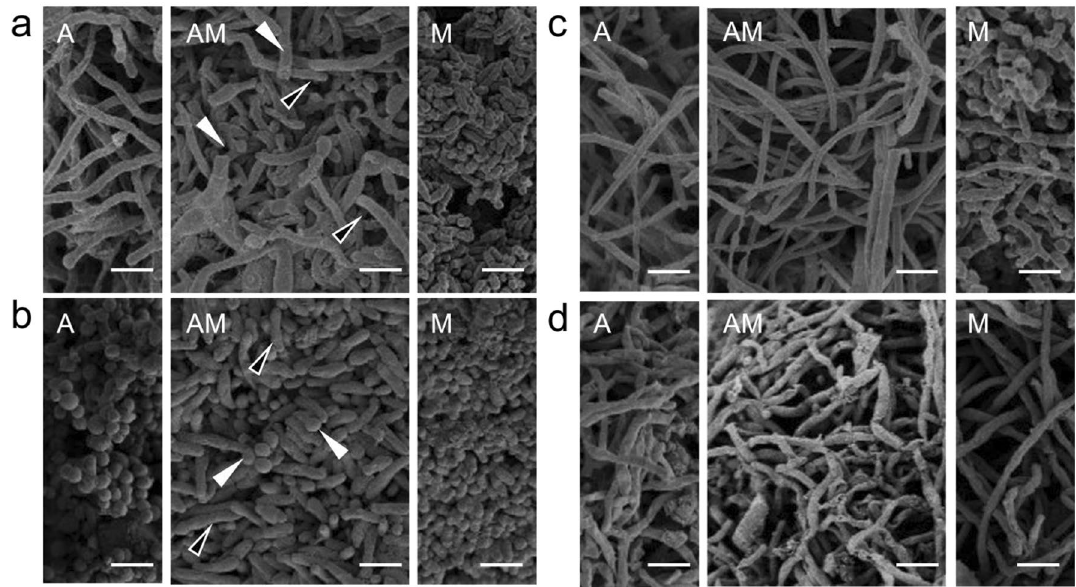
Figure 2. Scanning electron microscope image of co-isolated filamentous or cocci-shaped actinomycetes and mycolic acid-containing bacteria in combined-culture. ( a ) Left image: monoculture of HEK138A. Middle image: combined-culture of HEK138A/M. Right image: monoculture of HEK138M. White arrow indicates HEK138A filamentous cells and blank arrow indicates HEK138M bacilli-shaped cell. ( b ) Left image: monoculture of HEK904A. Middle image: combined-culture of HEK904A/M. Right image: monoculture of HEK904M. White arrow indicates HEK904A cocci-shaped cell and blank arrow indicates HEK904M cocci-shaped cell. ( c ) Left image: monoculture of HEK128A. Middle image: combined-culture of HEK128A/128 M. Right image: monoculture of HEK128M. ( d ) Left image: monoculture of HEK953A. Middle image: combined-culture of HEK953A/M. Right lower image: monoculture of HEK953M. (Scale bar = 2